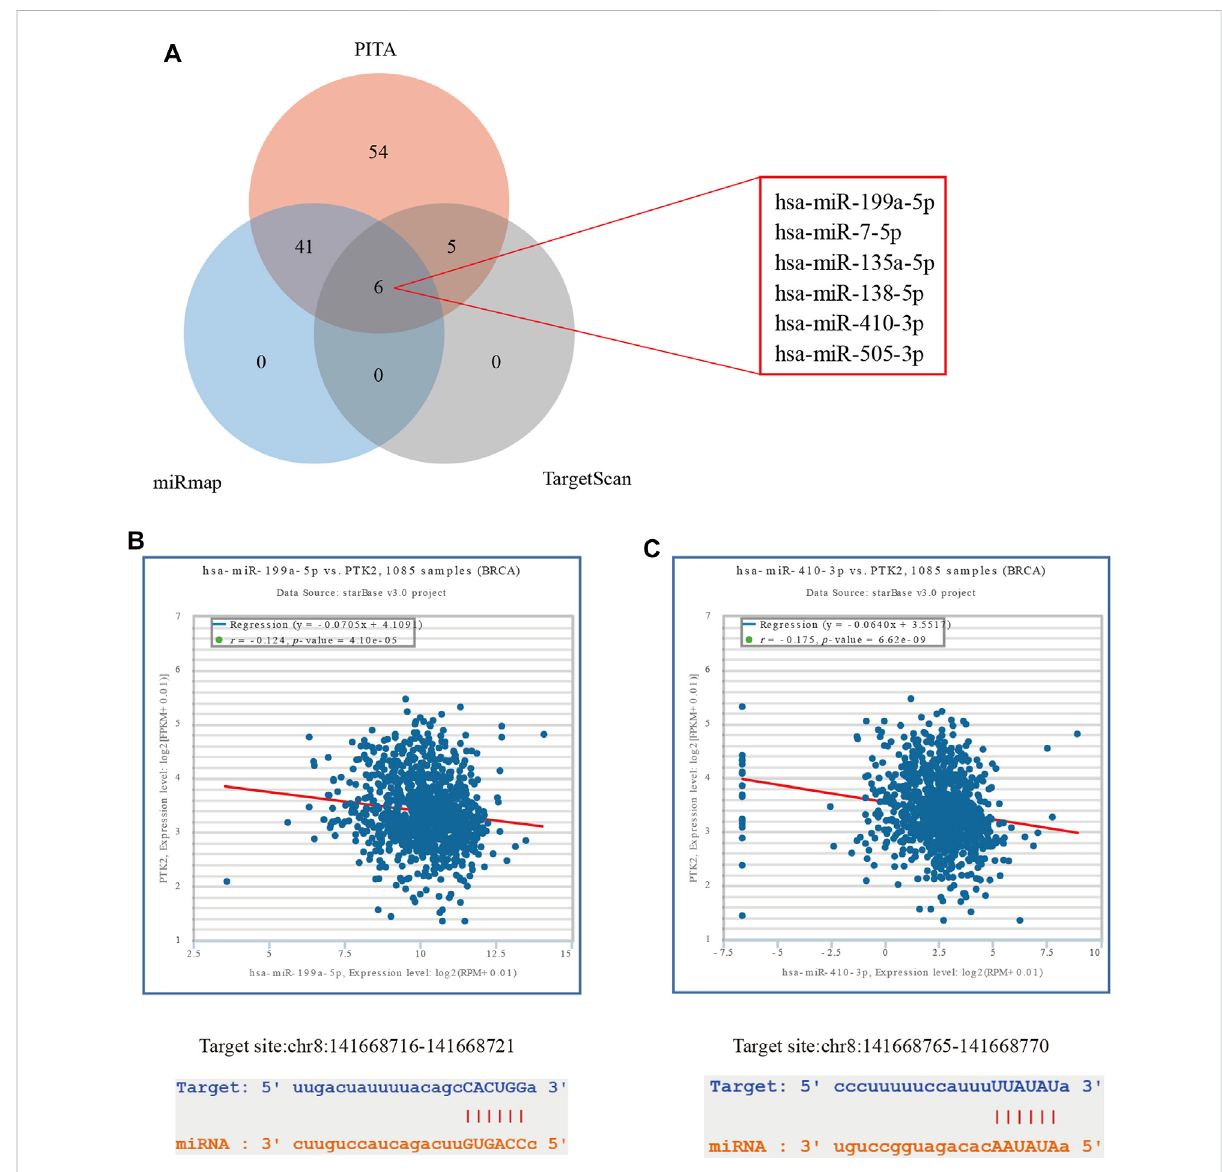
FIGURE 8 Predicting miRNAs targeting PTK2 in breast cancer. (A) Prediction results of PTK2 targets in the three databases PITA, miRmap, and TargetScan are shown by a Venn diagram. (B) starBase online database was used to analyze the correlation between PTK2 and target miRNAs. (C) TargetScan predicts the potential binding site of PTK2 to the target